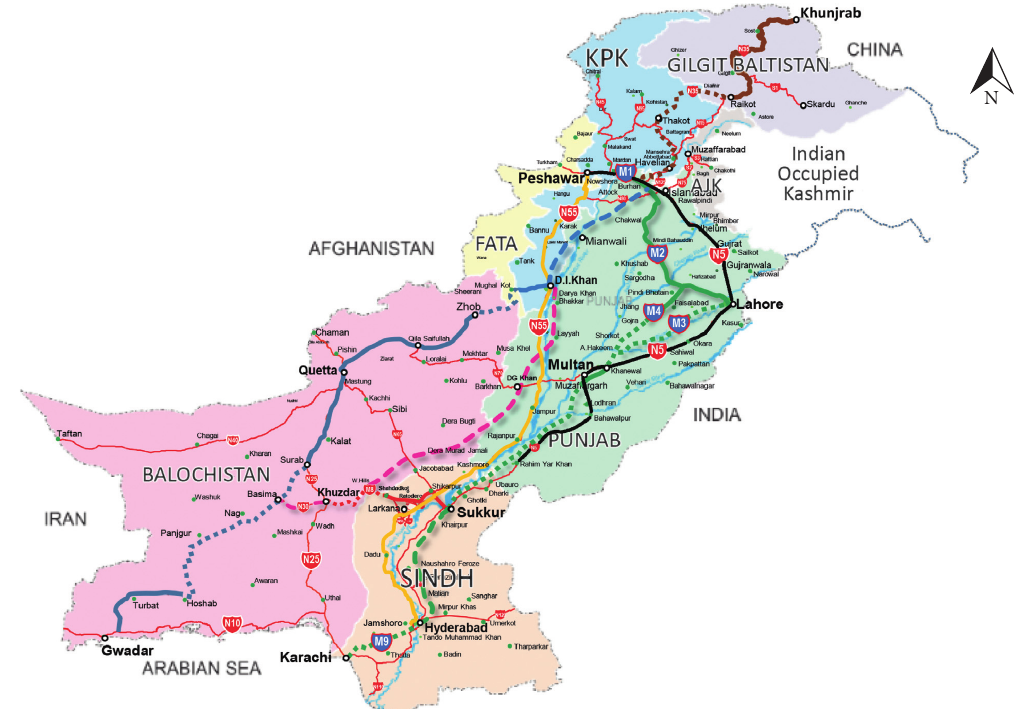
Figure 1: Segment of national highway-5 selected for the study. Table 1: Descriptive statistics of